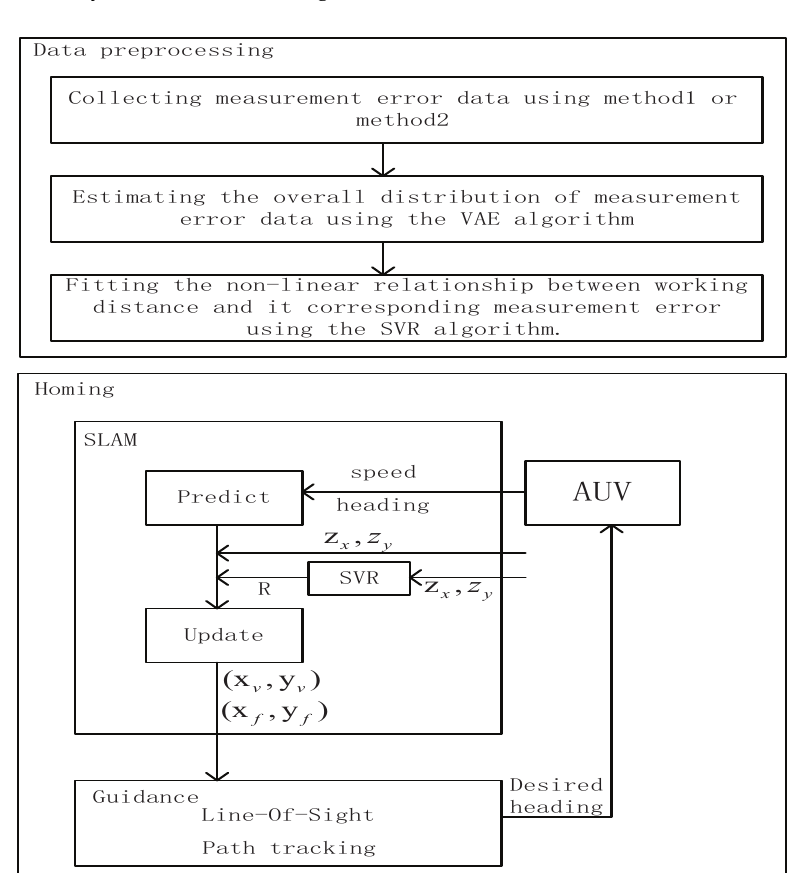
Figure 2. The overview of our recovery